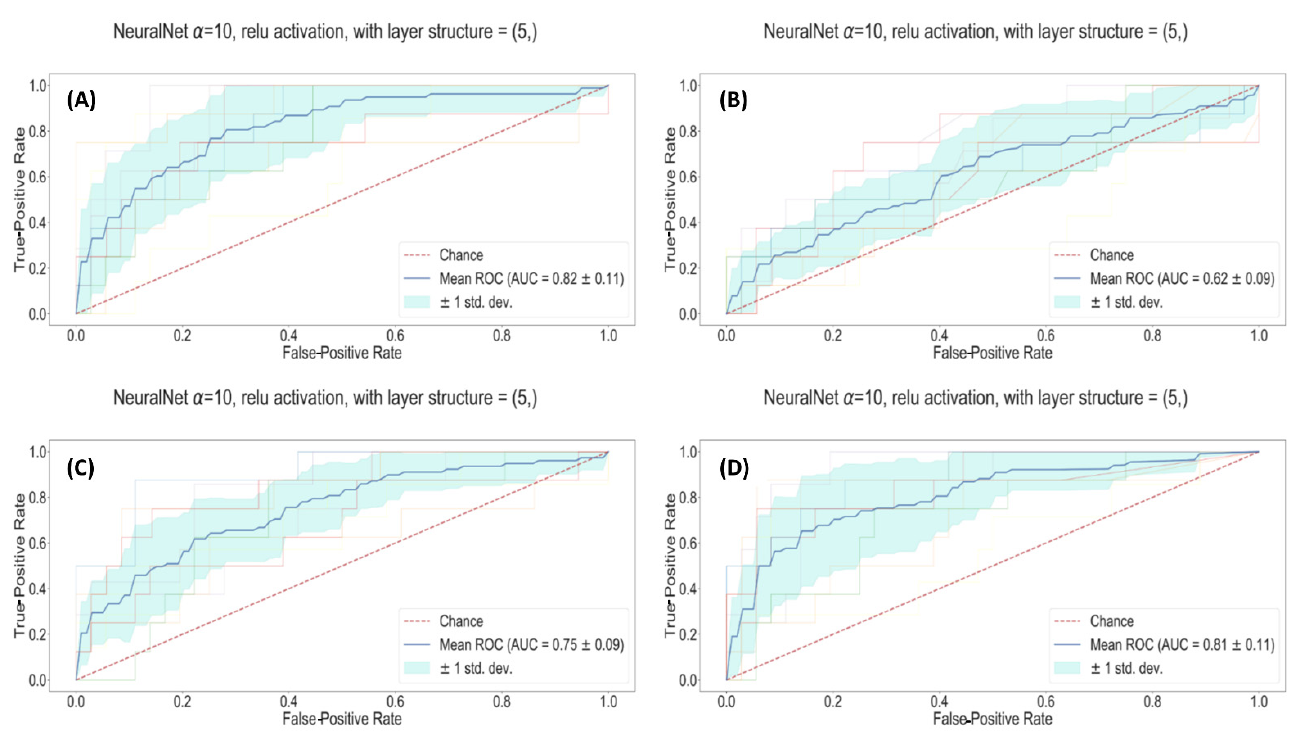
Figure 2. Performance of the Lasso regularized classifier on different input features: ( A ) Clinical, ( B ) Radiological, ( C ) Radiomic, and ( D ) All available features.